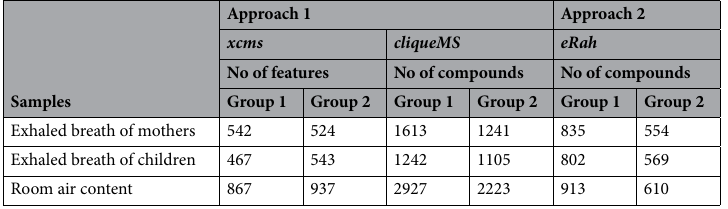
Table 1. Results obtained by both